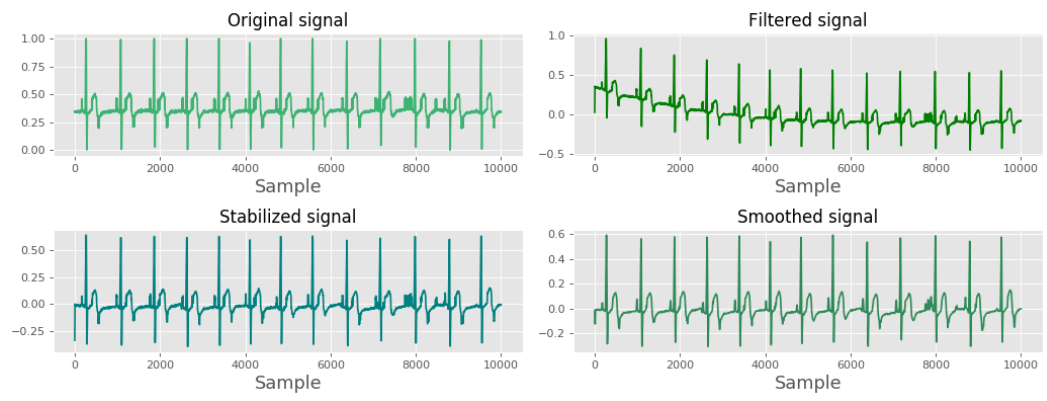
Figure 4. Pre-processing algorithm results.